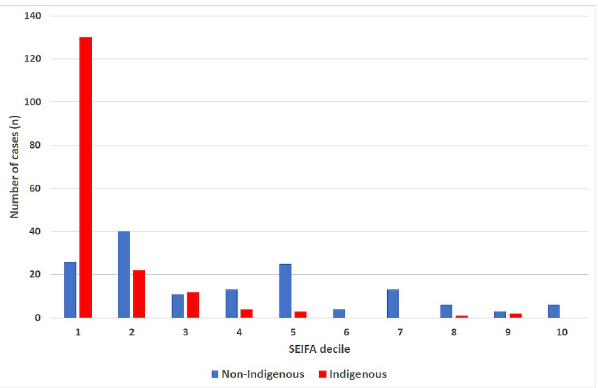
Fig 2. Socioeconomic disadvantage of people with melioidosis (determined using the SEIFA Index of Relative Socio-economic Disadvantage score), stratified by Indigenous status.